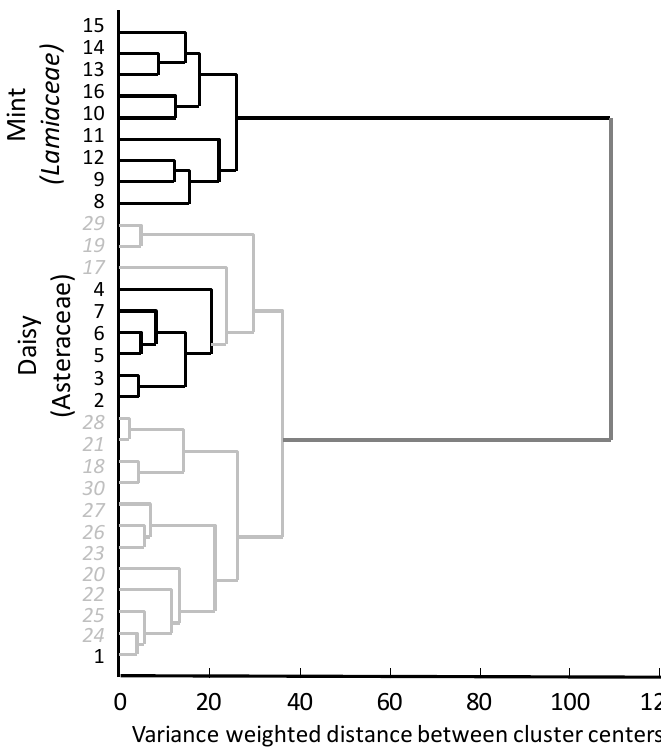
Figure 5. Hierarchical cluster analysis (HCA) of ATR-FTIR essential oil spectra.